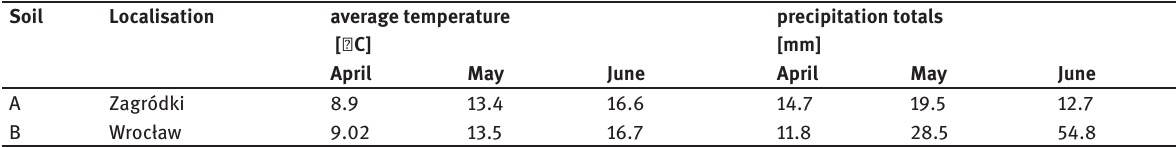
Table 3: Meteorological data.